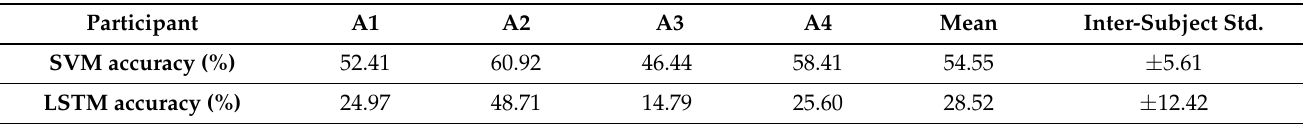
Table 10. Mean Leave-One-Subject-Out (LOSO) accuracies of each of the four lower limb-amputated subjects, using models trained only on individuals without gait impairment.